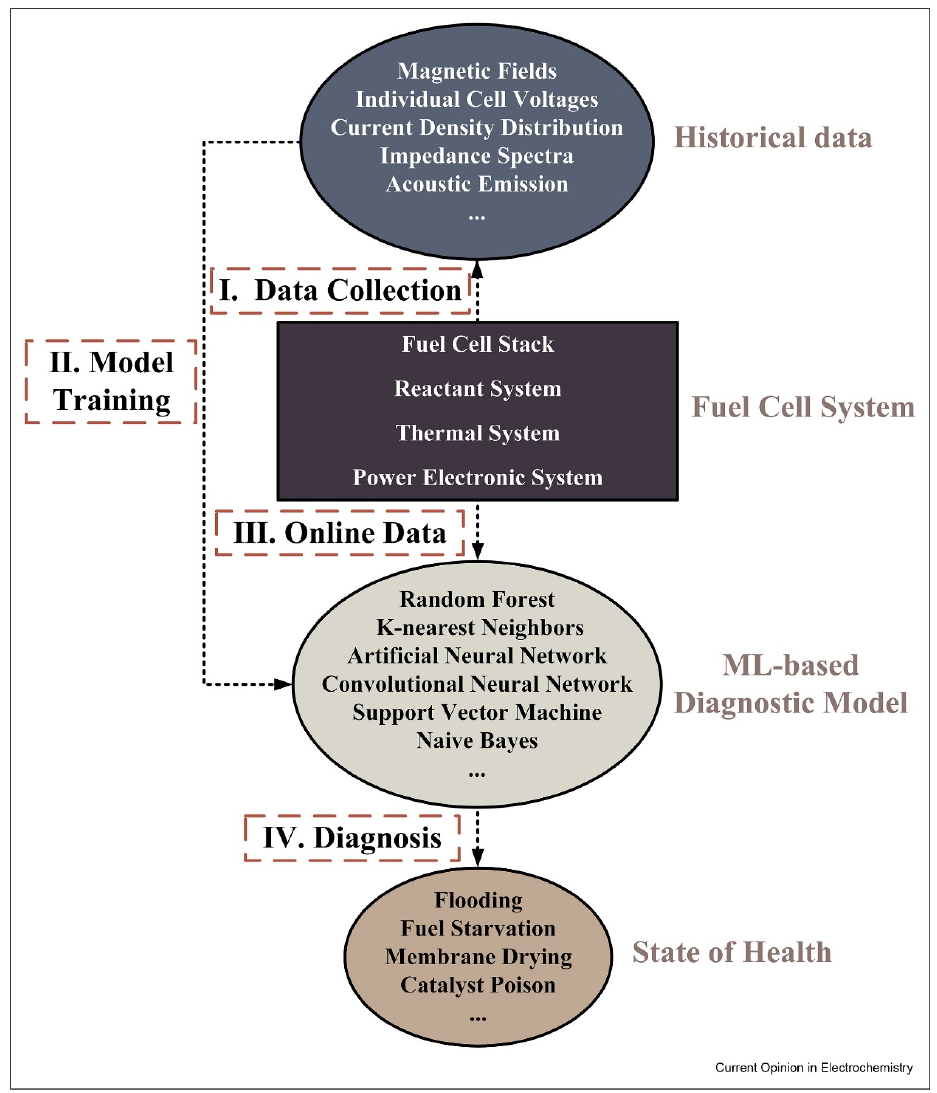
Figure 6. A flowchart depicting the use of machine learning-based diagnostic approaches on a FC system [83].